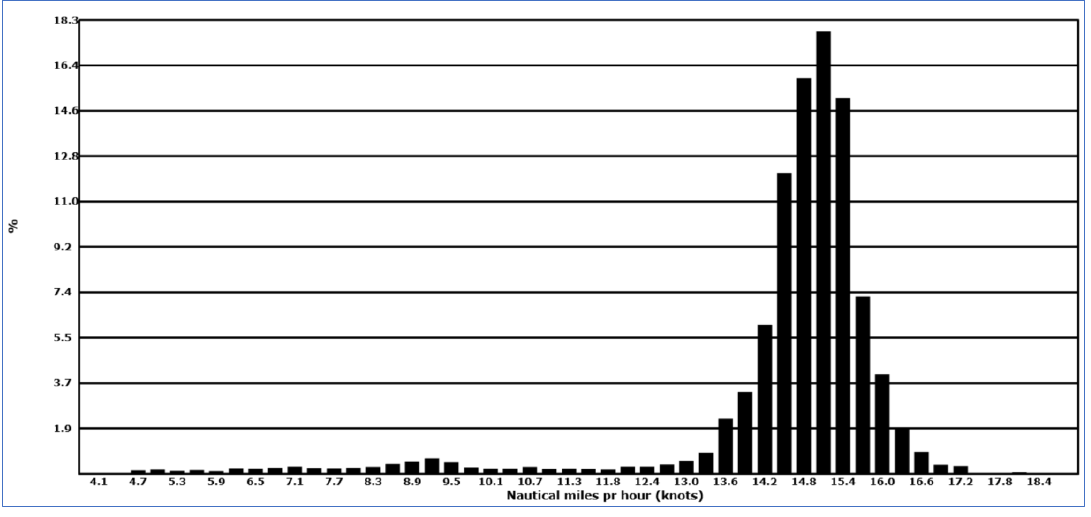
Figure 4. Speed profile for Finnmarken (May 2017).